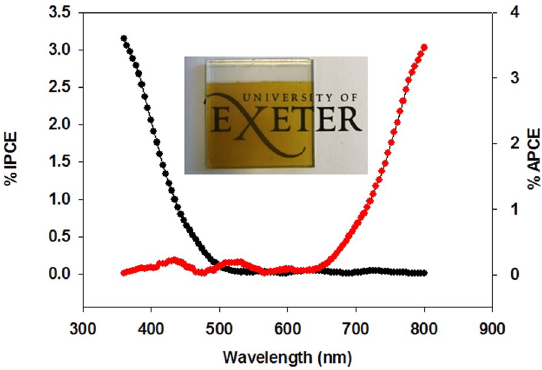
Figure 4. IPCE and APCE spectra for the nanostructured LaFeO 3 thin film.